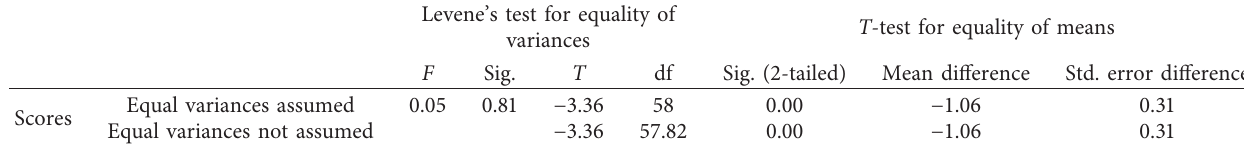
Table 4: Inferential statistics of the reading